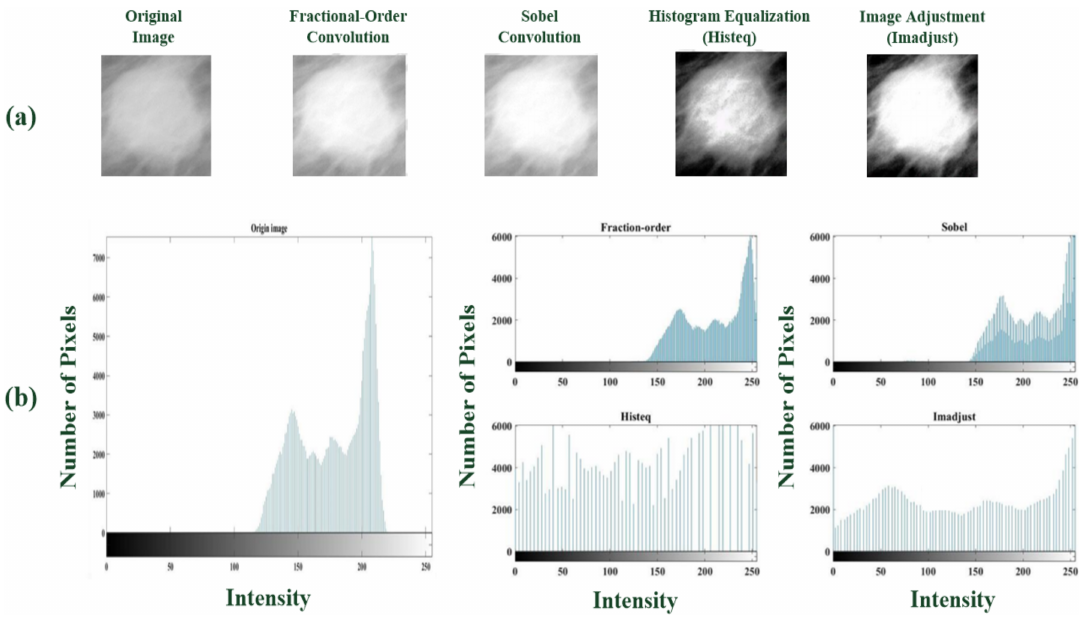
Figure 6. ( a ) The original image (malignant tumor) and the enhanced image of the three convolutions, ( b ) The original image and the pixel greyscale distribution map after image